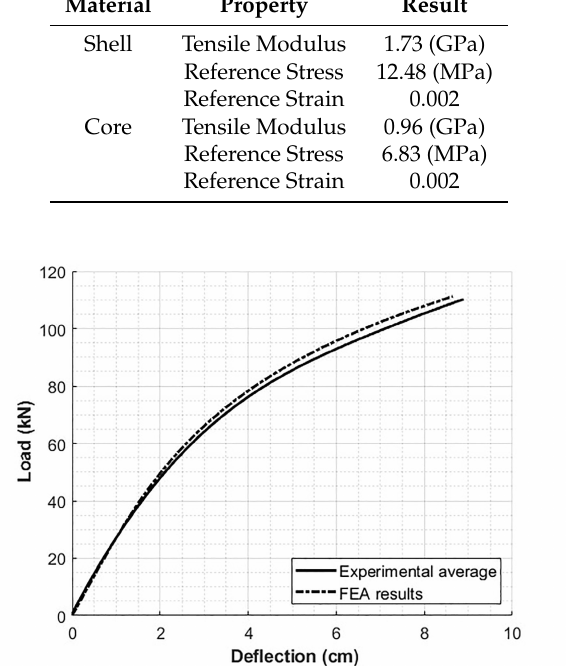
Figure 14. Non-linear FEA model using the Ramberg–Osgood model in comparison with the experimental four-point bend test